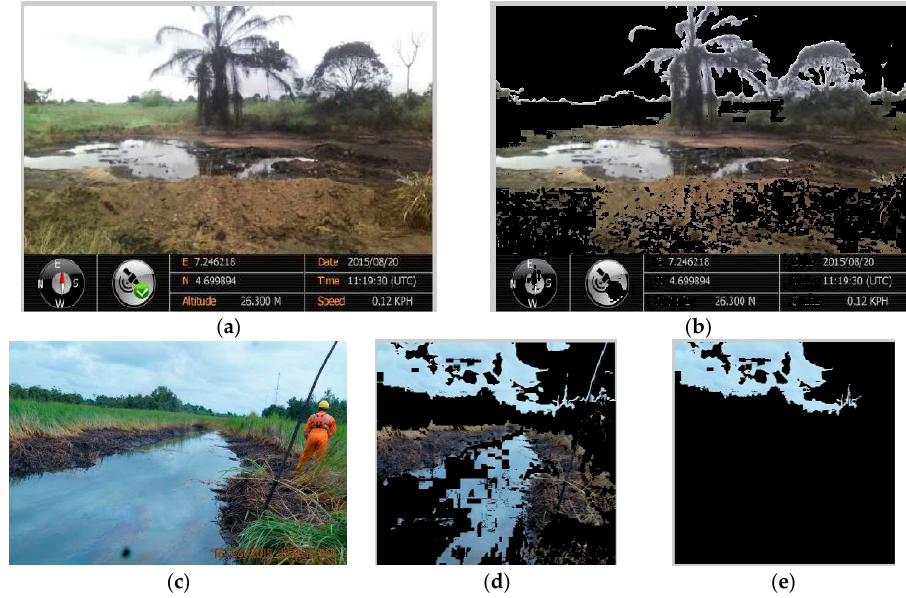
Figure 6. Sky Detection and Removal Stage. ( a ) Case Image OS63; ( b ) Effective Sky Detection and Removal for OS63; ( c ) Case Image OS51; ( d ) Ineffective Sky Detection and Removal for OS51; ( e ) Selection of Sky Region as primary ROI for OS51.